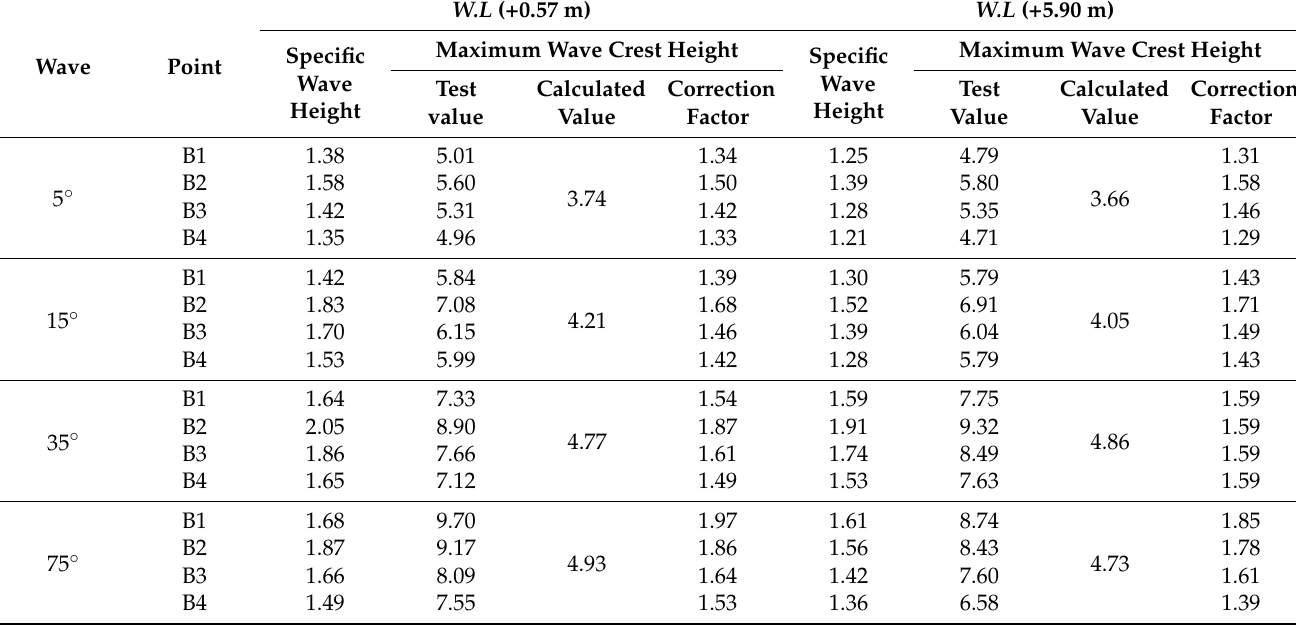
Table 4. Results of the wave height and wave crest